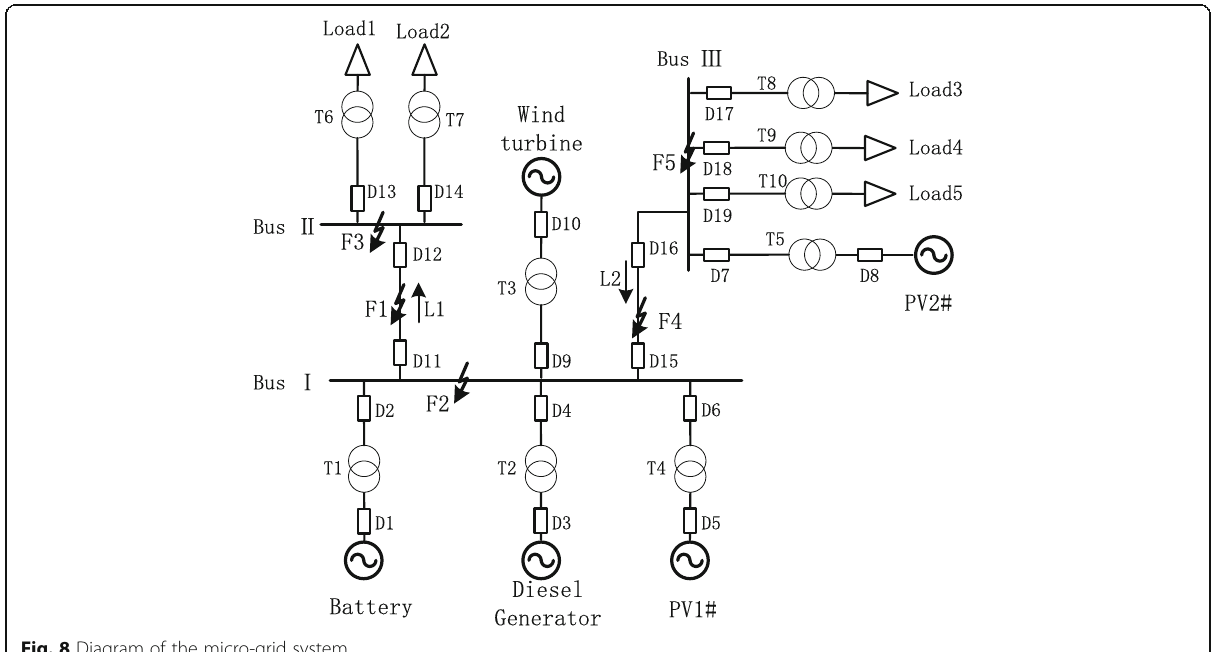
Fig. 8 Diagram of the micro-grid system